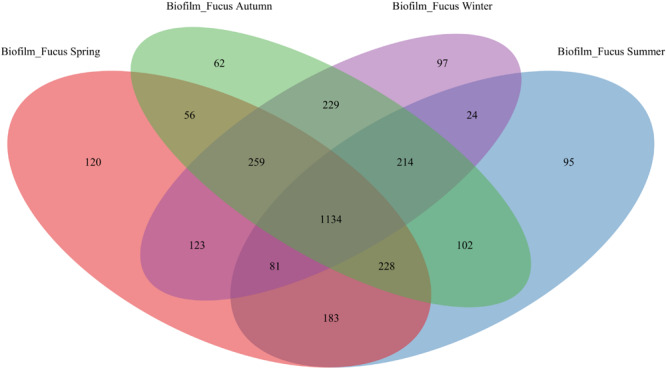
OTU overlap of biofilm bacterial communities among seasons. Venn diagram illustrating the counts of OTUs shared by Fucus vesiculosus biofilm (“Biofilm_Fucus”) bacterial communities among spring, summer, autumn, and winter.